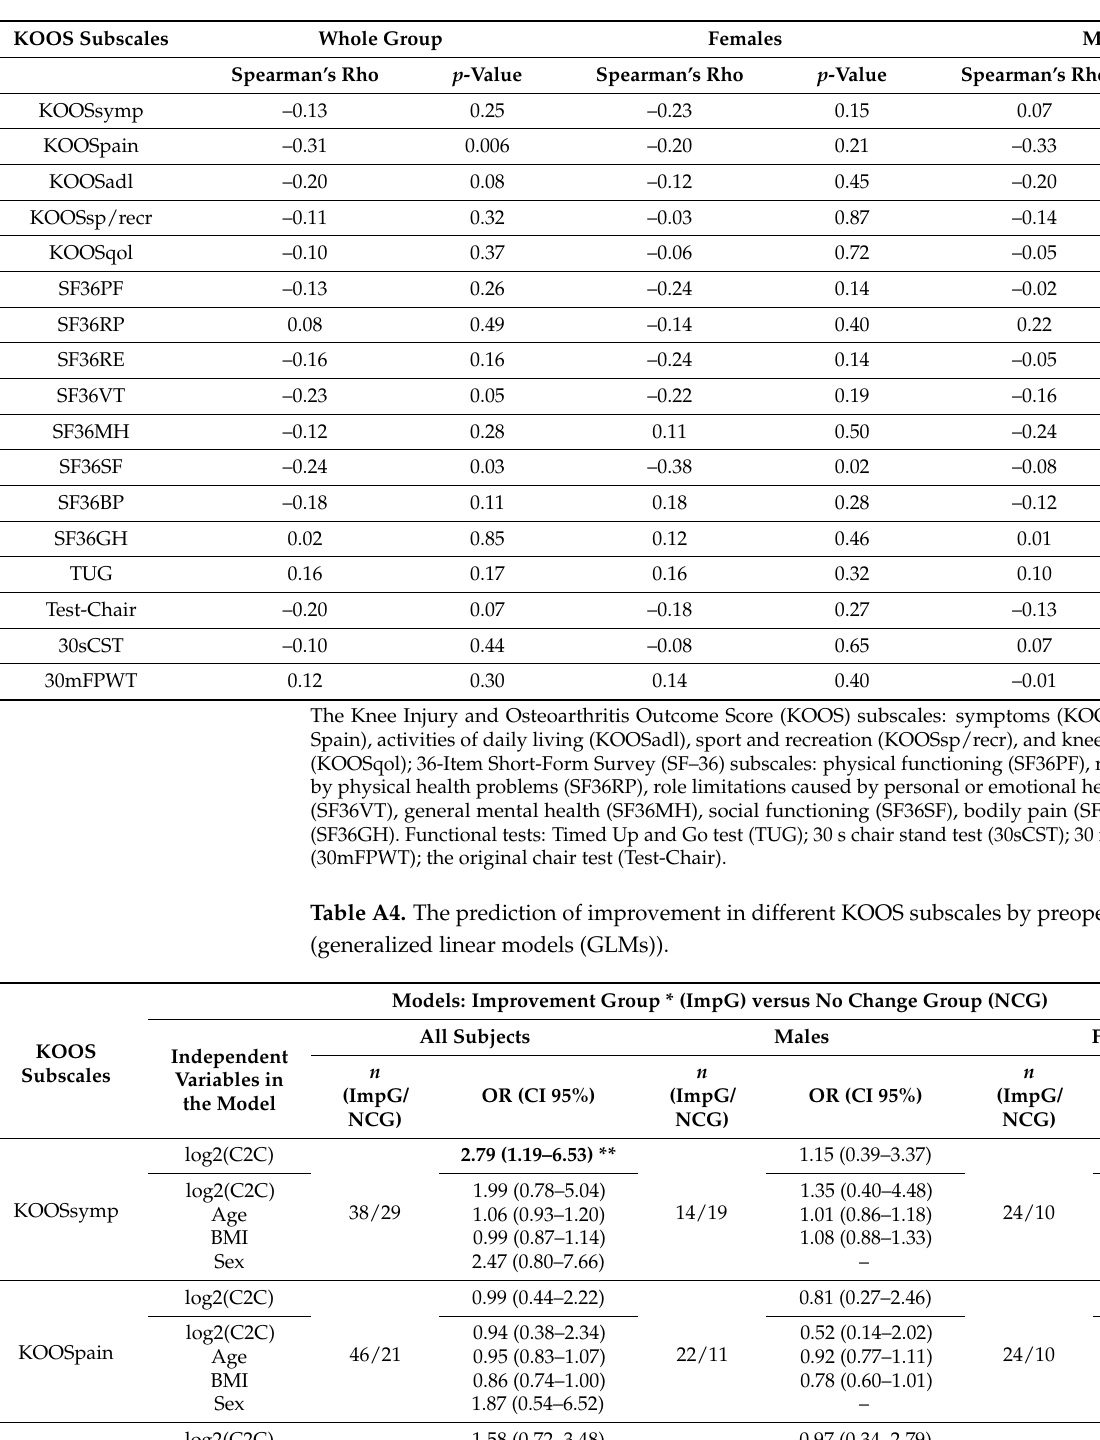
Table A3. Correlations between uC2C and results of subjective complaints or objective functional tests before TKR.